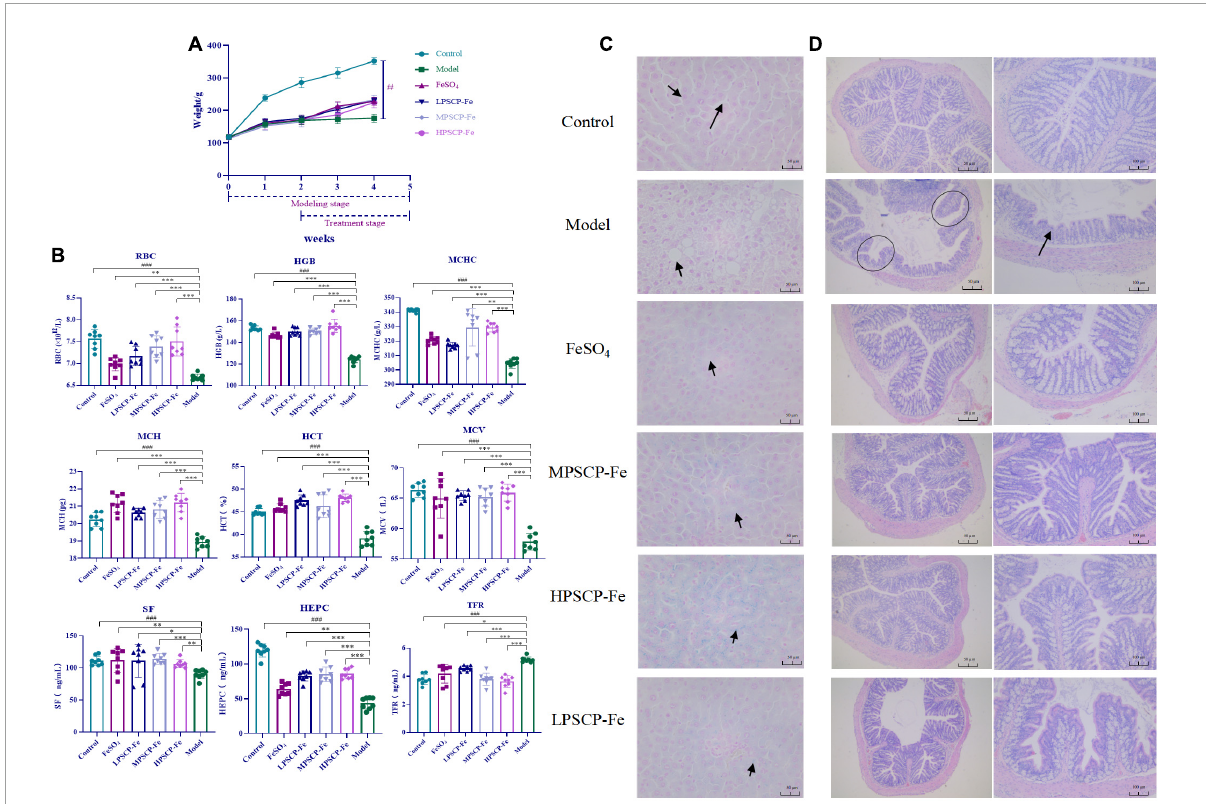
FIGURE2 Effects of PSCP-Fe on body weight (A) and blood routine parameters (B) in IDA rats. The data in the columns are expressed as the mean ± SD ( n = 8). Different marks ( # , ∗ ) indicate differences at the p < 0.05 level. ### p < 0.001: Control vs. Model; ∗ p < 0.05, ∗∗ p < 0.01, and ∗∗∗ p < 0.001: Treatments vs. Model. Liver iron staining evaluation by Prussian blue staining method (C) , × 400 magnification. Evaluate the histopathology changes of the rats colon tissues by H&E staining (D)